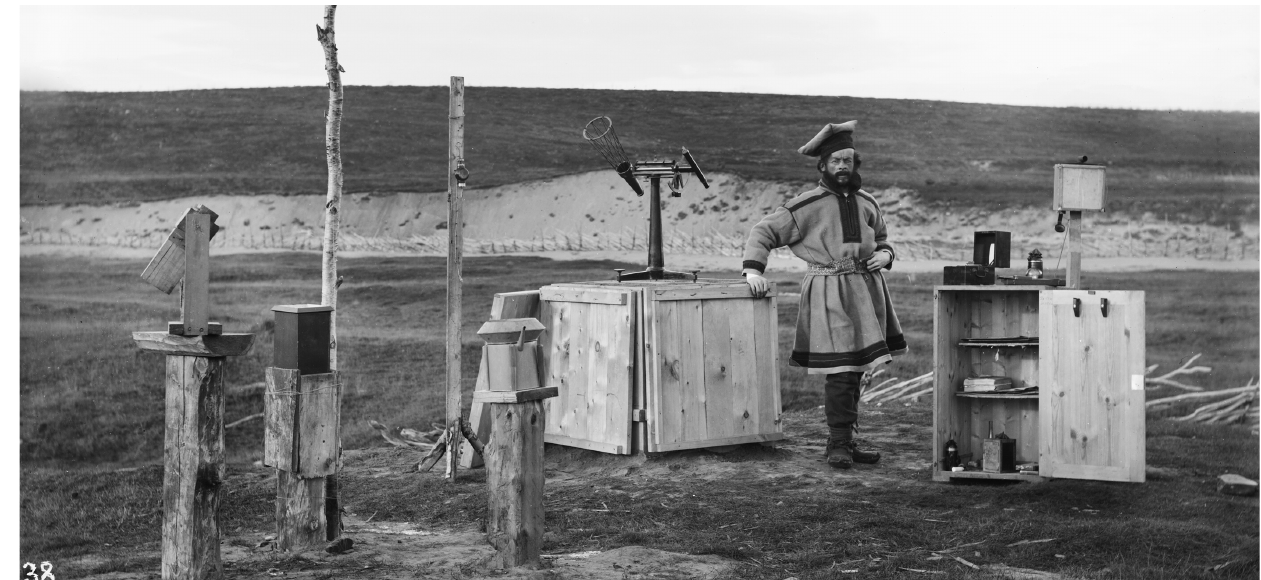
Figure 4. Tromholt in Sami costume standing among the instruments in his ”observatory” in Kautokeino (Tromholt, from photo collection held at University of Bergen Library,